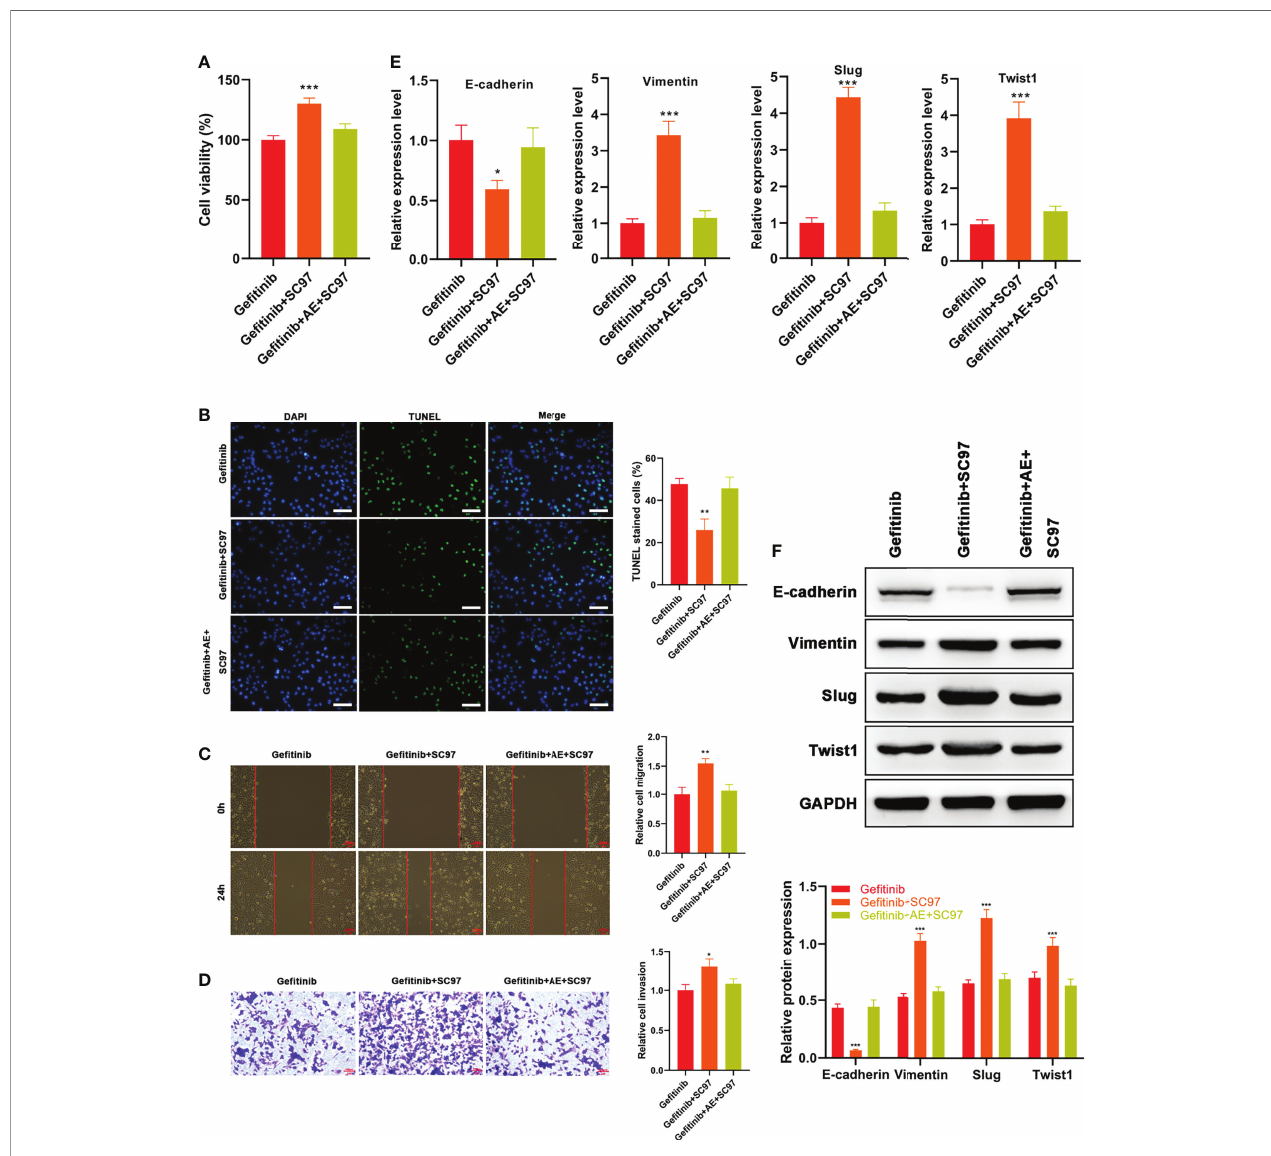
FIGURE 5 | AE Strengthened the Ge fi tinib Sensitivity of PC9-GR Cells by Reversing EMT Via PI3K/Akt/TWIS1 Pathway. (A) Relative cell viability of PC9-GR cells treated with different treatments (B) TUNEL assay results, (C) wound healing assay results, (D) Transwell assay results, (E) qPCR results of EMT-related genes, and (F) WB results of EMT-related genes in PC9-GR cells after different treatments. Scale bar = 100 m m. *p<0.05, **p<0.01,